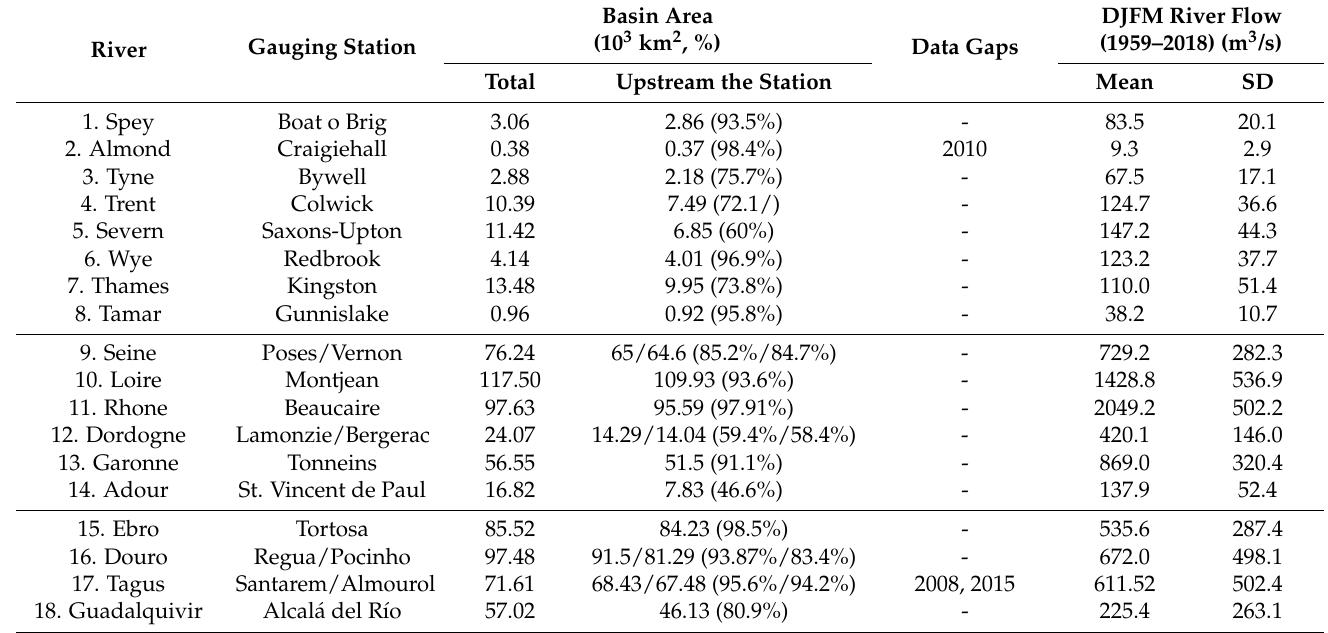
Table 1. Main characteristics of the 18 river basins under